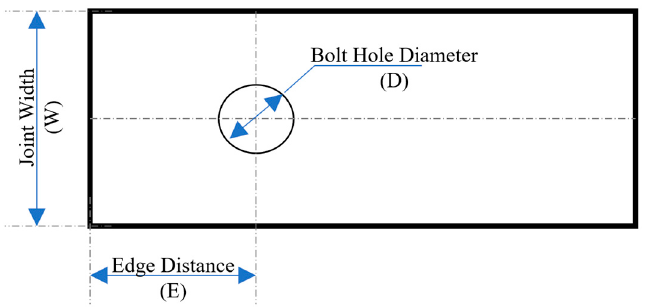
Figure 1. The bolted composite plate geometric parameters.